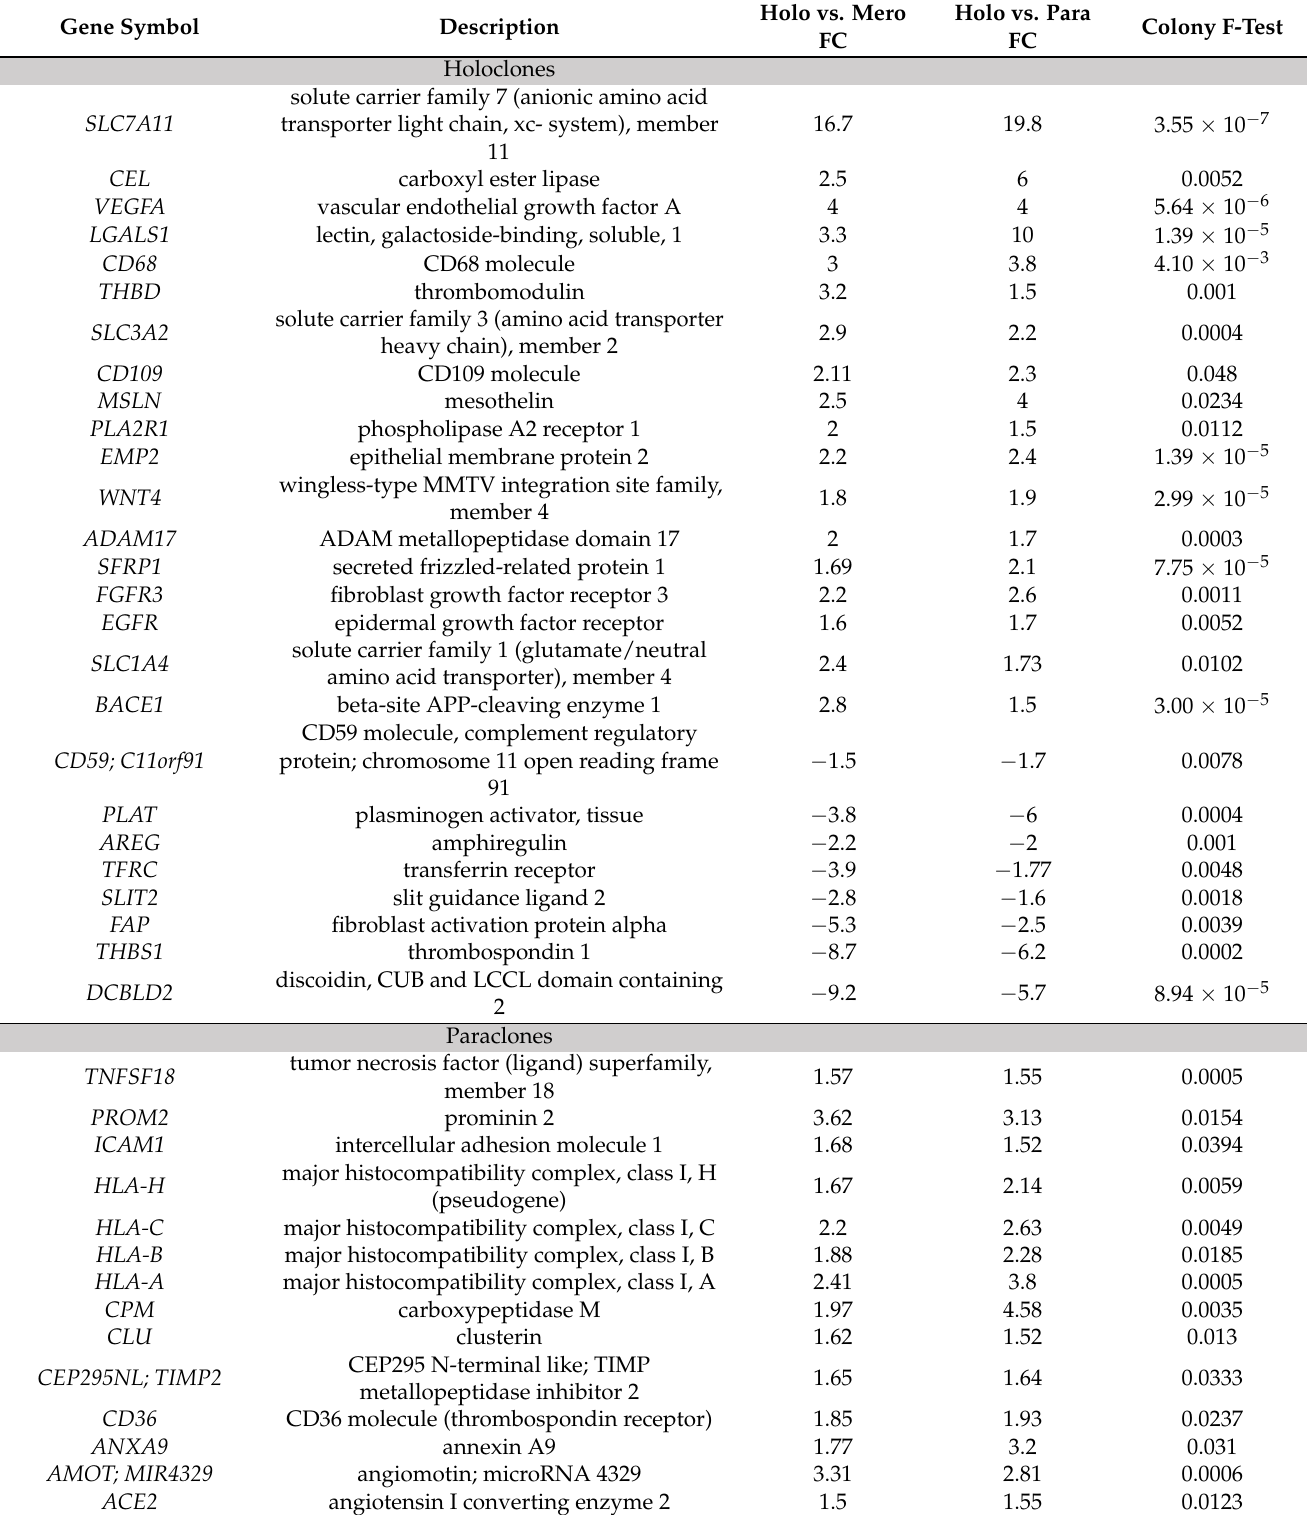
Table 2. List of the gene expression levels of cell surface markers revealed by microarray analysis. Gene Symbol